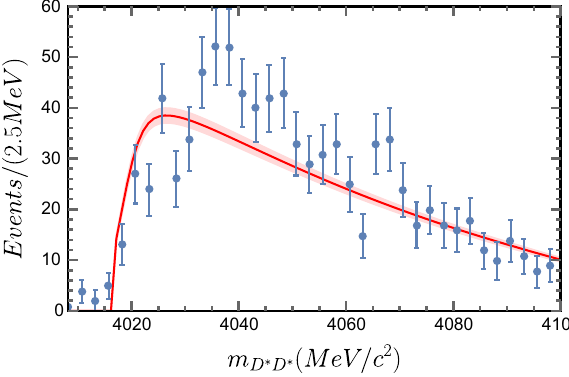
√ Fig. 3 Line shapes for D ∗ ¯ D ∗ at s = 4 . 26 GeV. Experimental data are from Ref. [17]. The theoretical line shapes have been convoluted with the experimental resolution. The line-shape’s 68%-uncertainty is shown as a shadowed area